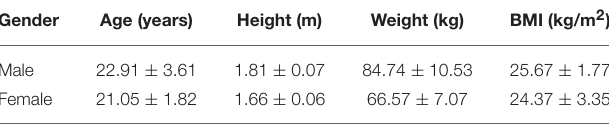
TABLE 2 | Traditional linear measures of spatial patterns associated with CoM